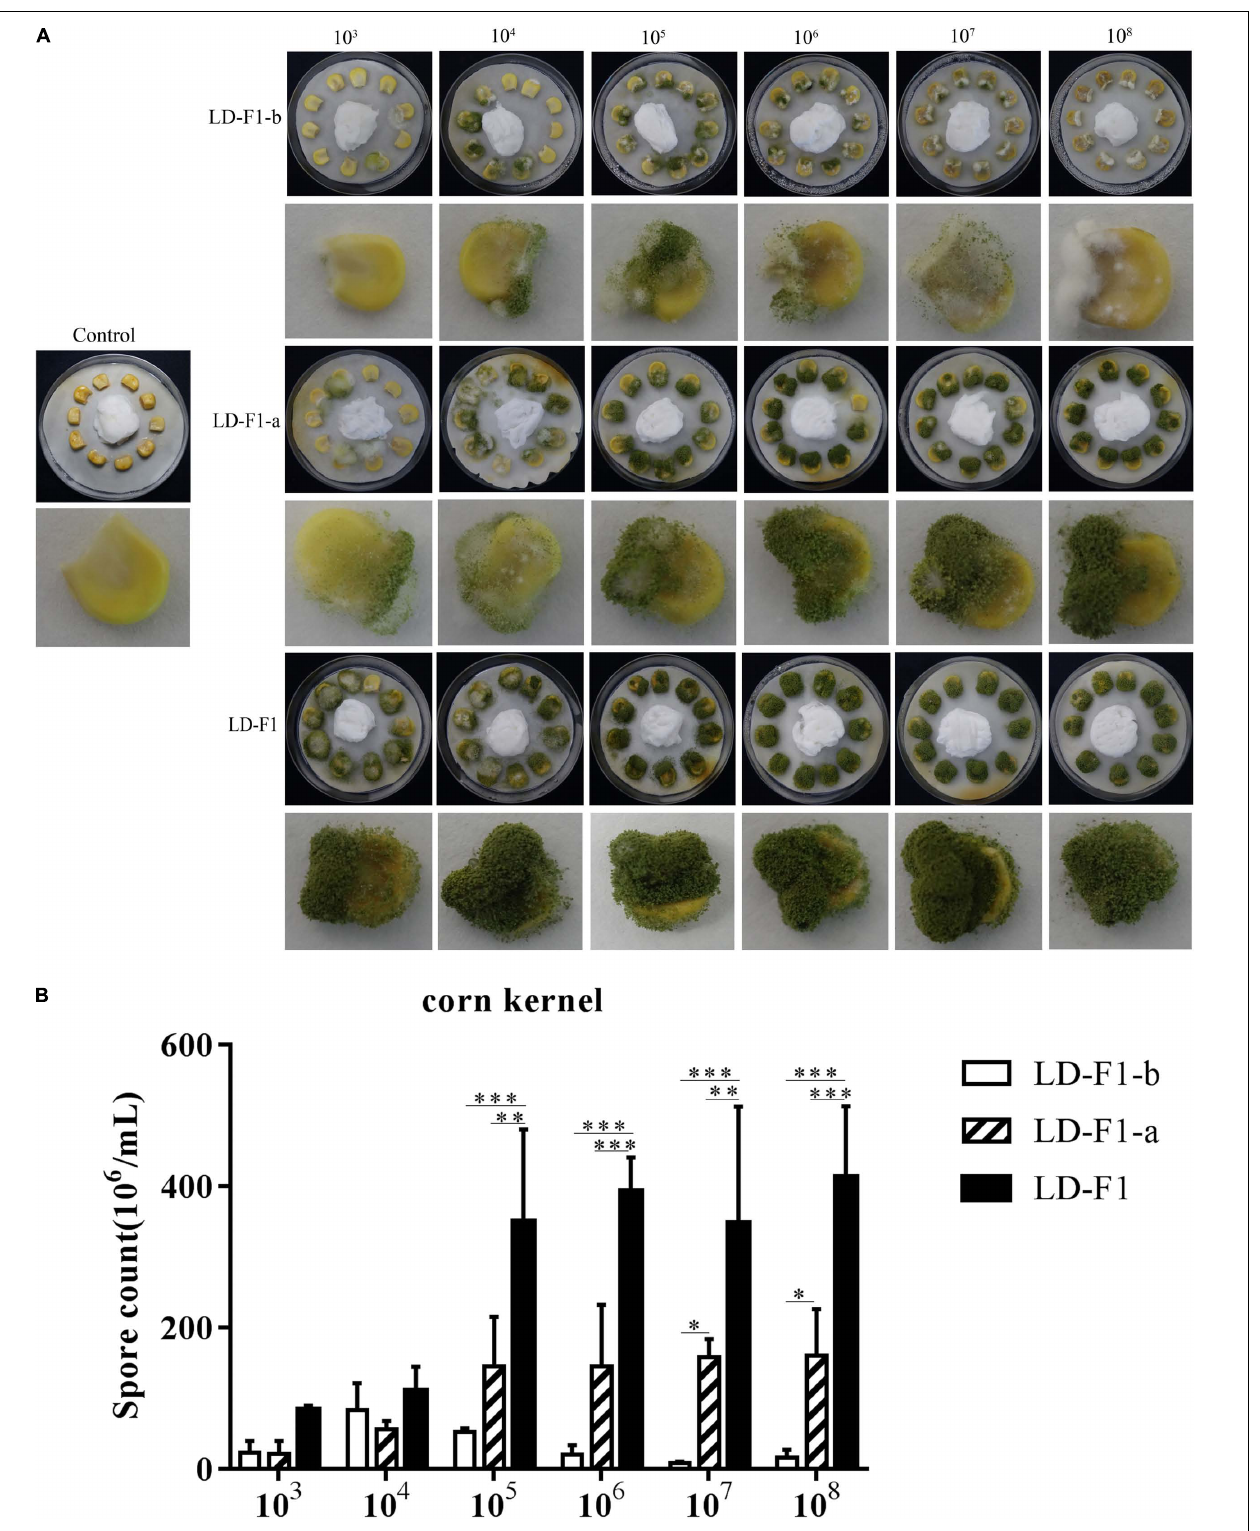
FIGURE 5 | (A) Colonization of virus-free isolate (LD-F1), AfPV1-infected isolate (LD-F1-b), and AfPV1- and SatRNA-infected isolate (LD-F1-a) on maize kernel. (B) Conidia production of virus-free isolate (LD-F1), AfPV1-infected isolate (LD-F1-b), and AfPV1- and SatRNA-infected isolate (LD-F1-a) was assessed on infected maize kernels. ∗ P < 0.05, ∗∗ P < 0.01, ∗∗∗ P < 0.001, by Tukey’s multiple comparison tests.